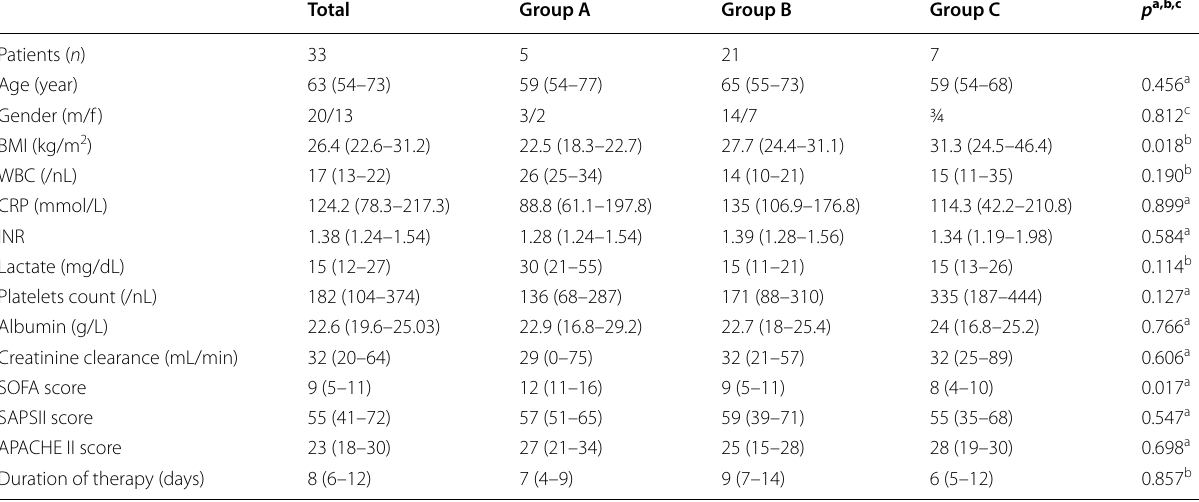
Table 2 Baseline characteristics